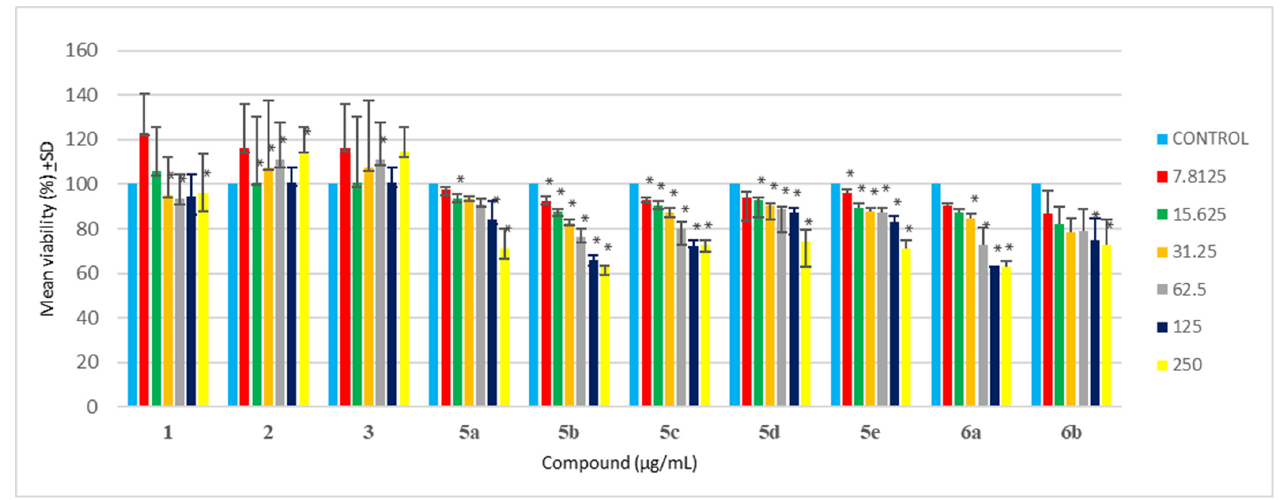
Figure 2. Cytotoxicity analysis of synthesized compounds against HEK-293 cells (Where, * p < 0.05).